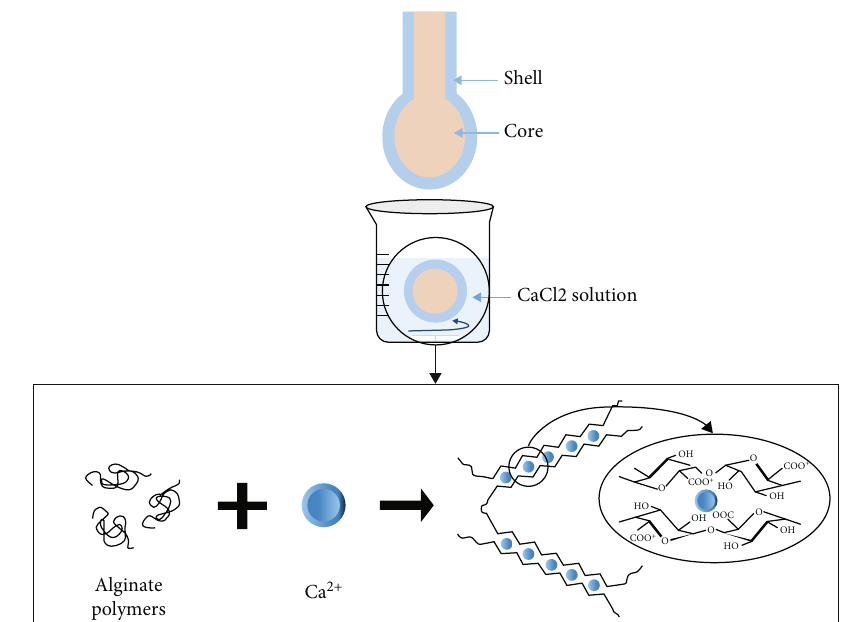
Figure 3: Capsule production process. A capsule is formed by coextrusion of the core solution (water or oil) and the alginate solution. When dropped into a calcium bath, the alginate instantly gels to form a capsule with a liquid core and a hydrogel membrane [39, 41, 42].